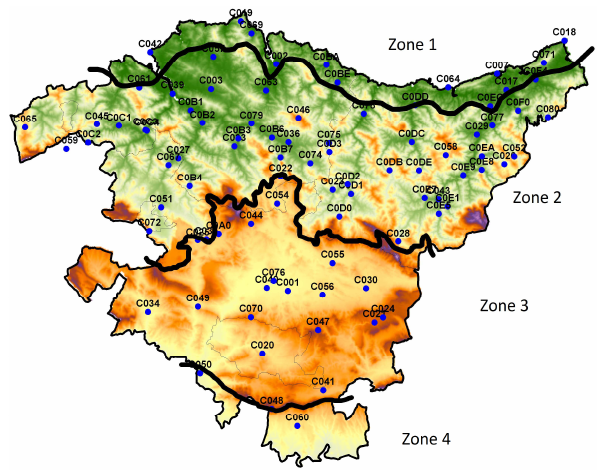
Figure 4 . Temperature warnings areas and temperature sensor distribution. 3 Figure 4. Temperature warnings areas and temperature sensor dis-